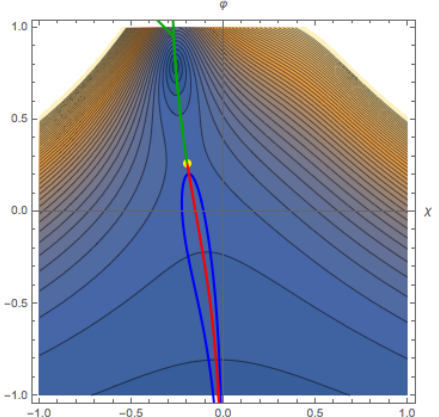
Figure 3 . Contour plot of the G 2 -invariant superpotential and (cid:13)ows. The N = 1, G 2 critical point is denoted by a yellow dot. The 3d N = 8 SYM phase is located at (cid:31) = 0 and ’ ! (cid:0)1 .